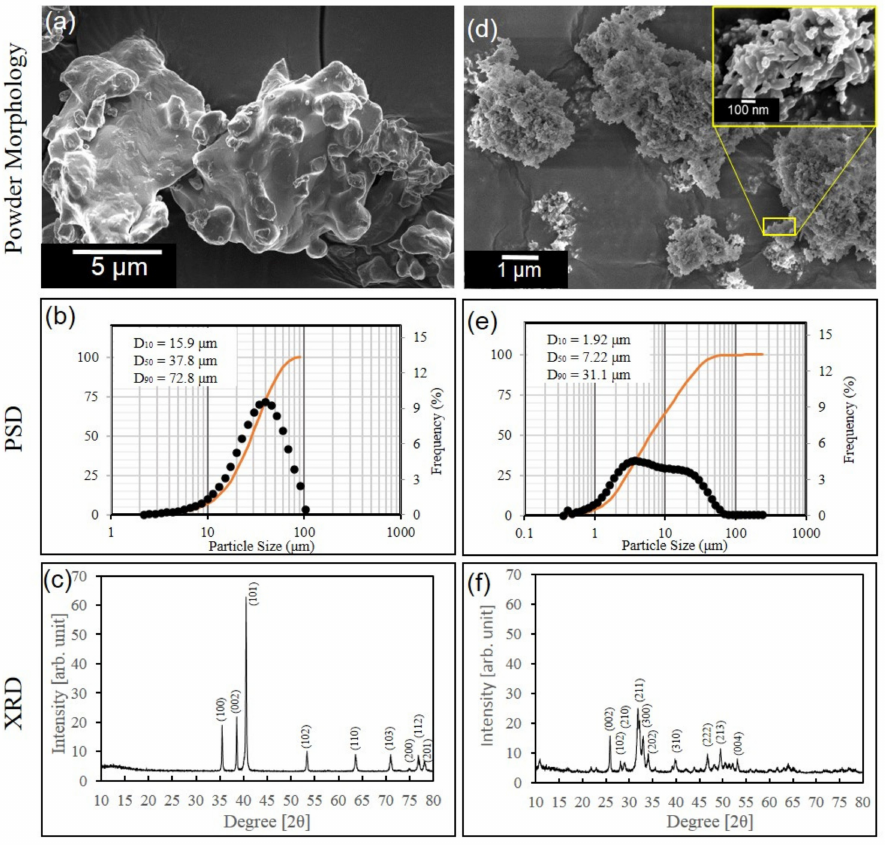
Figure 2. Powder morphology of raw powder ( a ) Ti6Al4V, ( d ) HA, particle size distribution of raw powder ( b ) Ti6Al4V, ( e ) HA, and X-ray diffraction pattern of raw powder ( c ) Ti6Al4V, ( f )